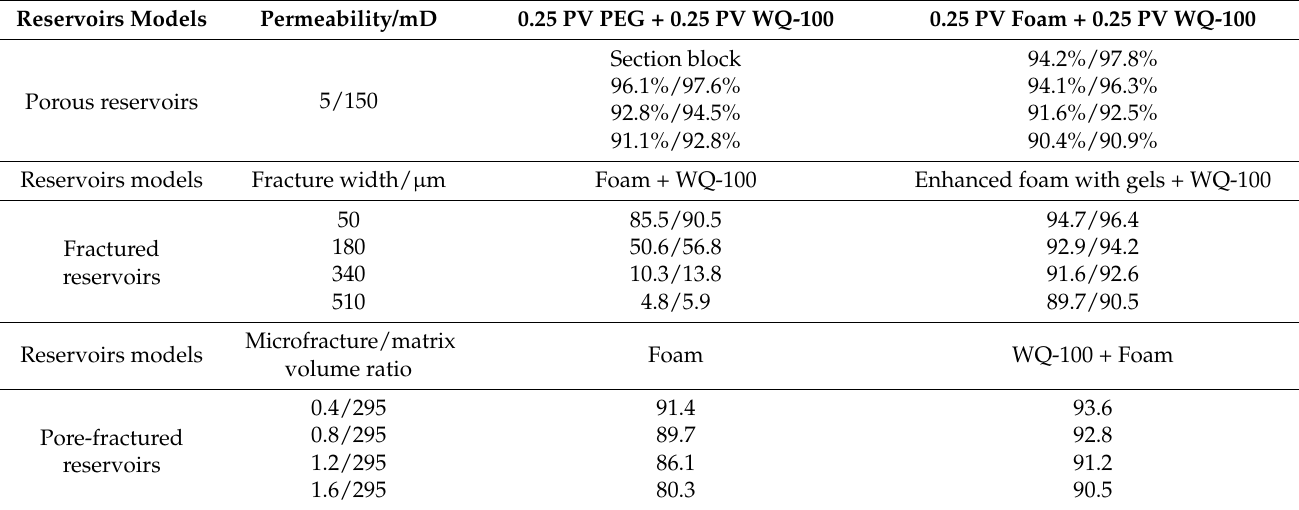
Table 9. Plugging efficiency of enhanced foam system in varying reservoir models.